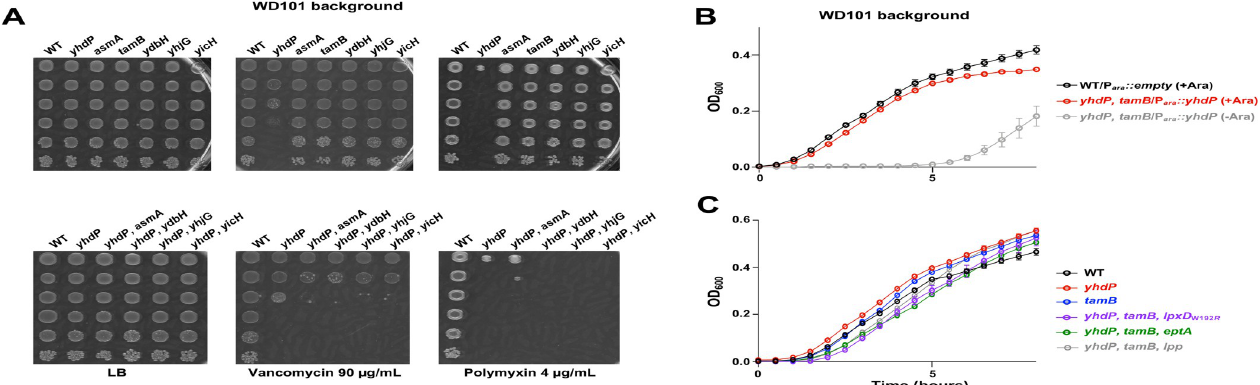
Fig 3. Impact on growth and antibiotic resistance in strains lacking AsmA-like proteins. (A) YhdP homologues are not essential for polymyxin or vancomycin resistance in WD101. Serial dilutions of the indicated strains were spotted on LB plates containing either polymyxin or vancomycin and grown at 37˚C. (B) Loss of yhdP and tamB in polymyxin resistant WD101 is synthetically lethal. The strain yhdP , tamB/ P with 0.2% arabinose (+Ara, red) or under repressing conditions with 0.2% glucose (-Ara, grey) at 37˚C. (C) Lowering LPS levels or lipid A modifications allows for deletion of both yhdP and tamB in WD101. The indicated strains were grown at 37˚C. Error bars represent SD from technical triplicates. Data is representative of 3 biological replicates.